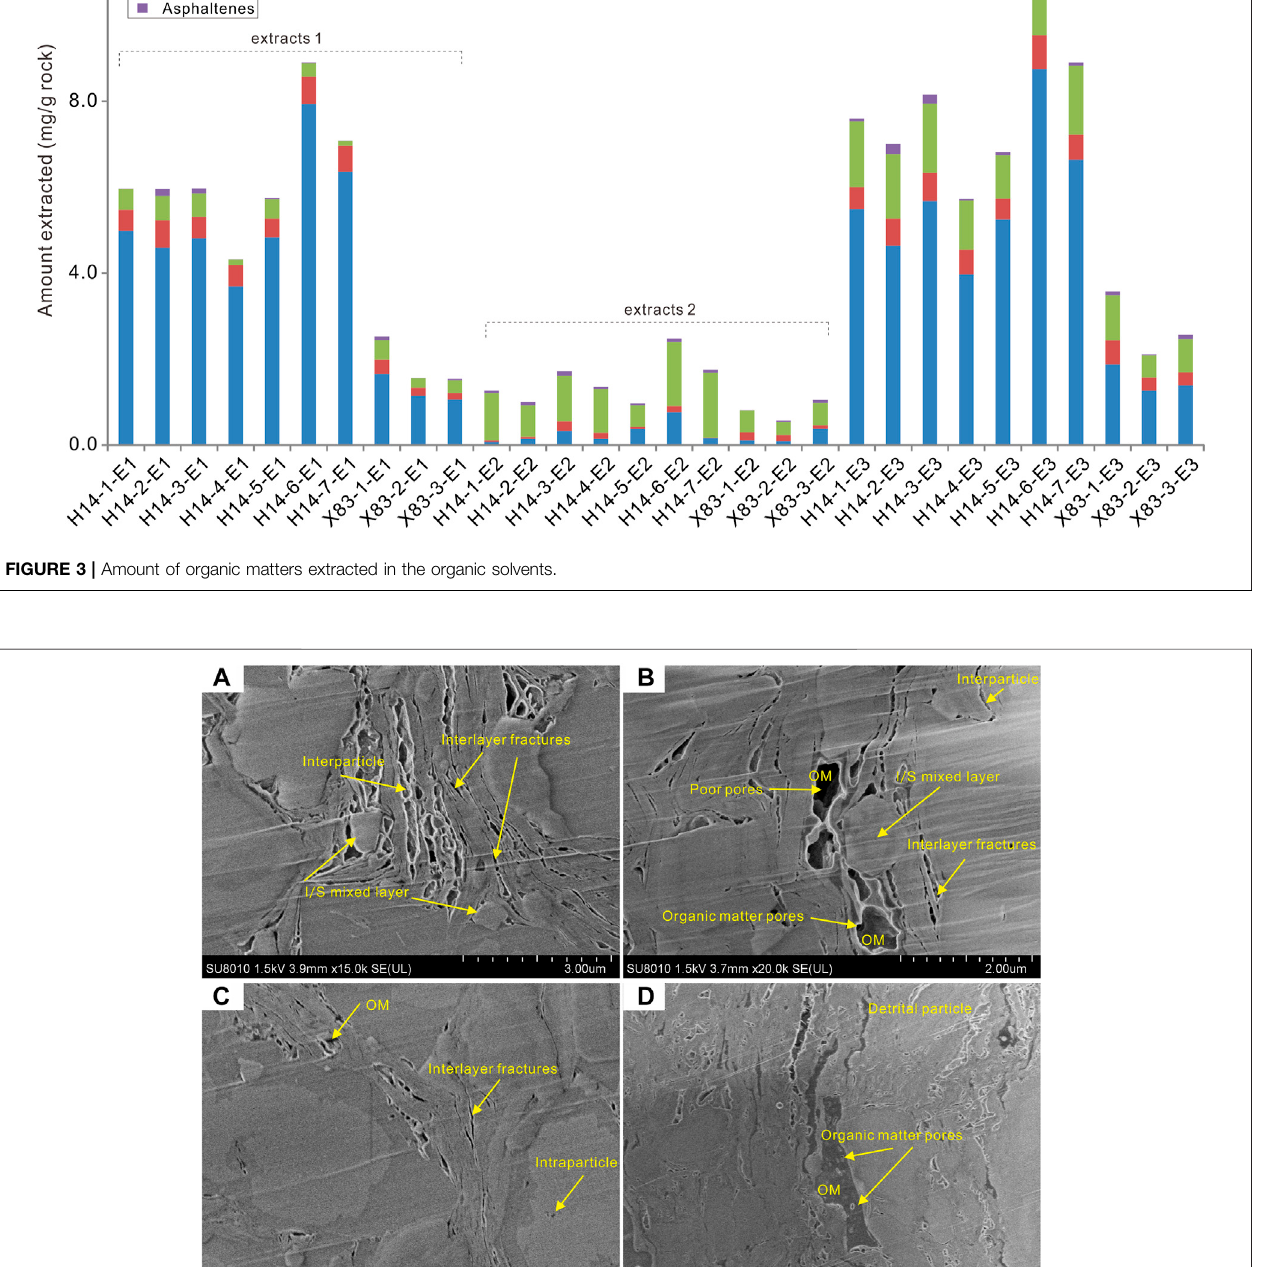
Frontiers in Earth Science |